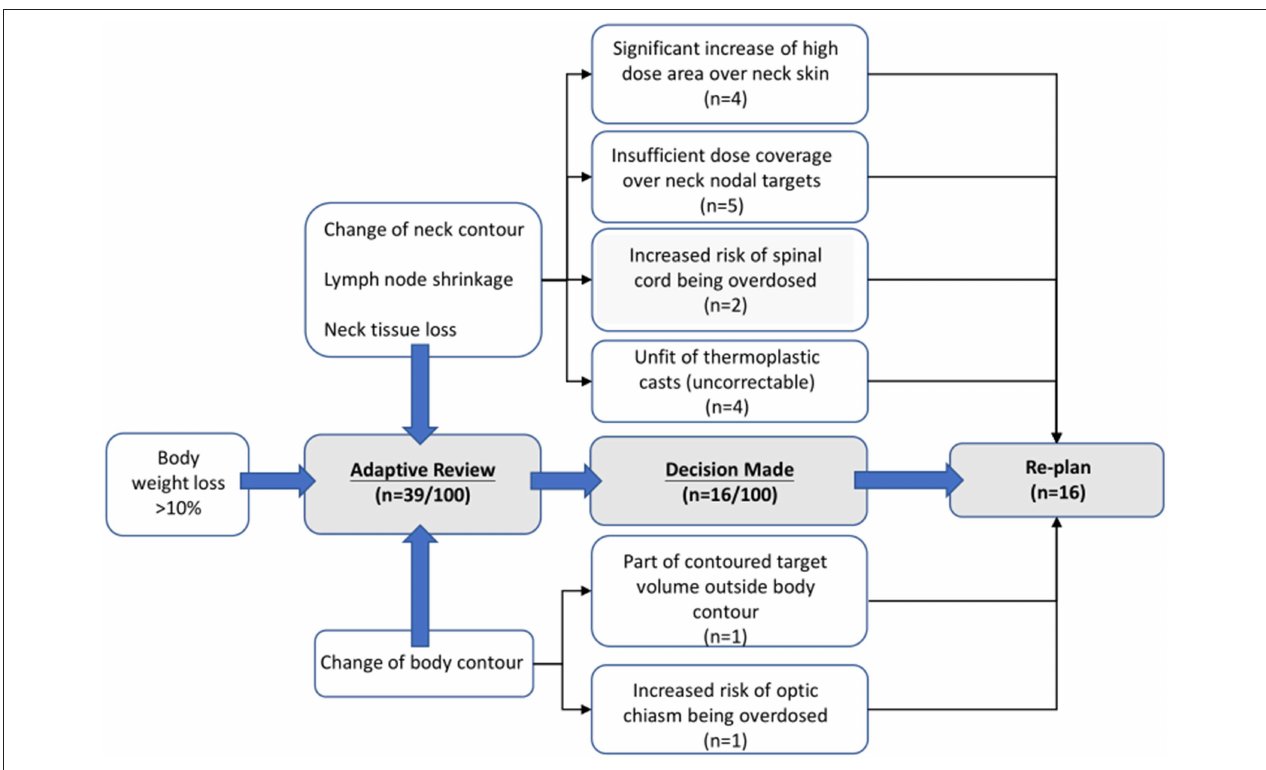
FIGURE 2 | An illustrative example of clinical decision on ART implementation.